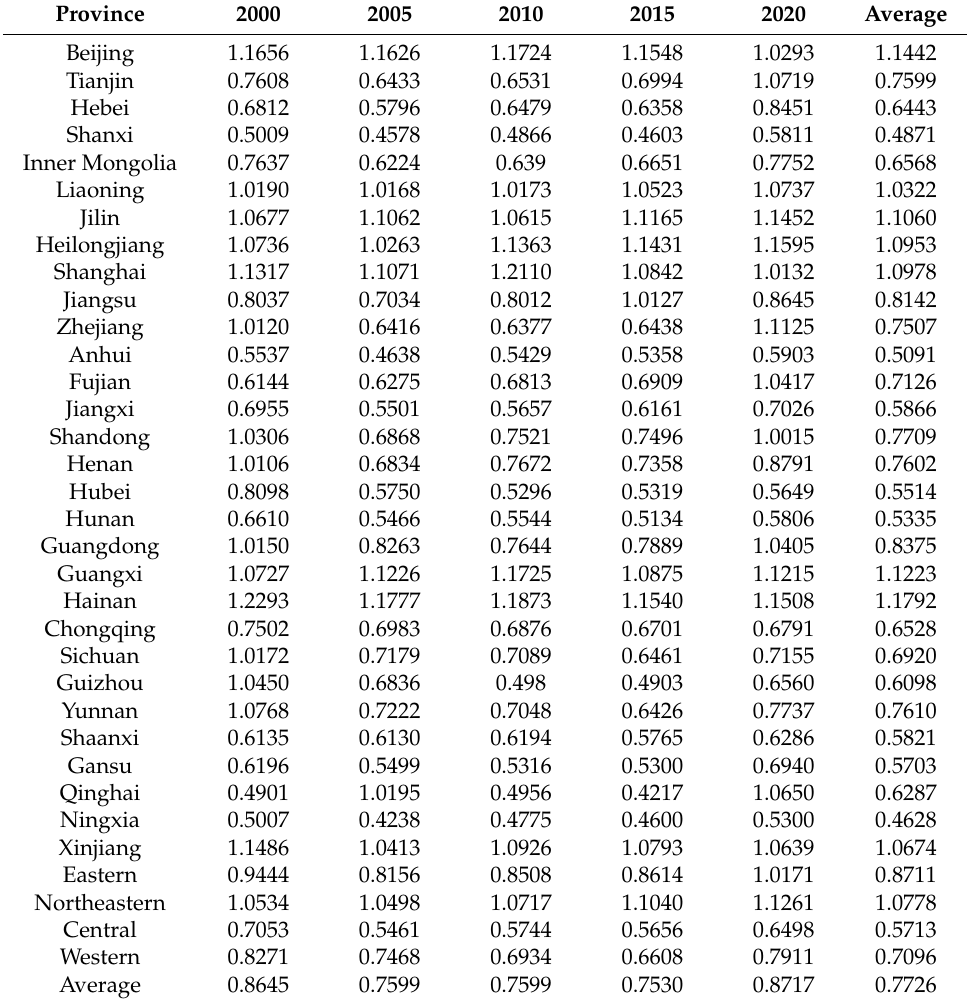
Table 4. AEE in 30 Chinese provinces in major